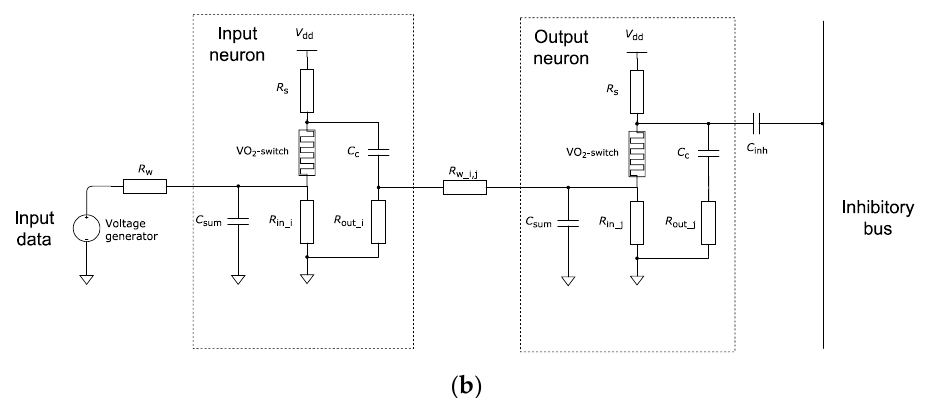
Figure 6. ( a ) Architecture of a two-layer neural network for pattern recognition and ( b ) circuit implementation of neurons in the input and output layers.